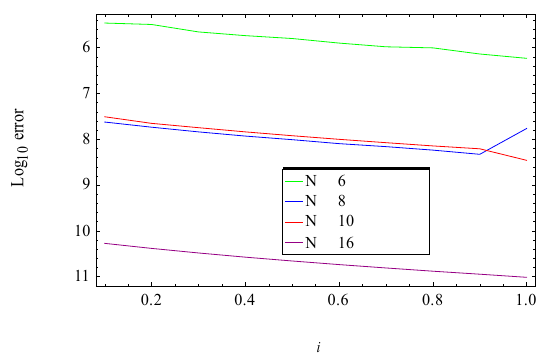
Mathematics 2019 , 7 , x FOR PEER REVIEW Figure 2. Error functions for the present method at different N values. Figure 2. Error functions for the present method at di Figure 2. Error functions for the present method at different N values.